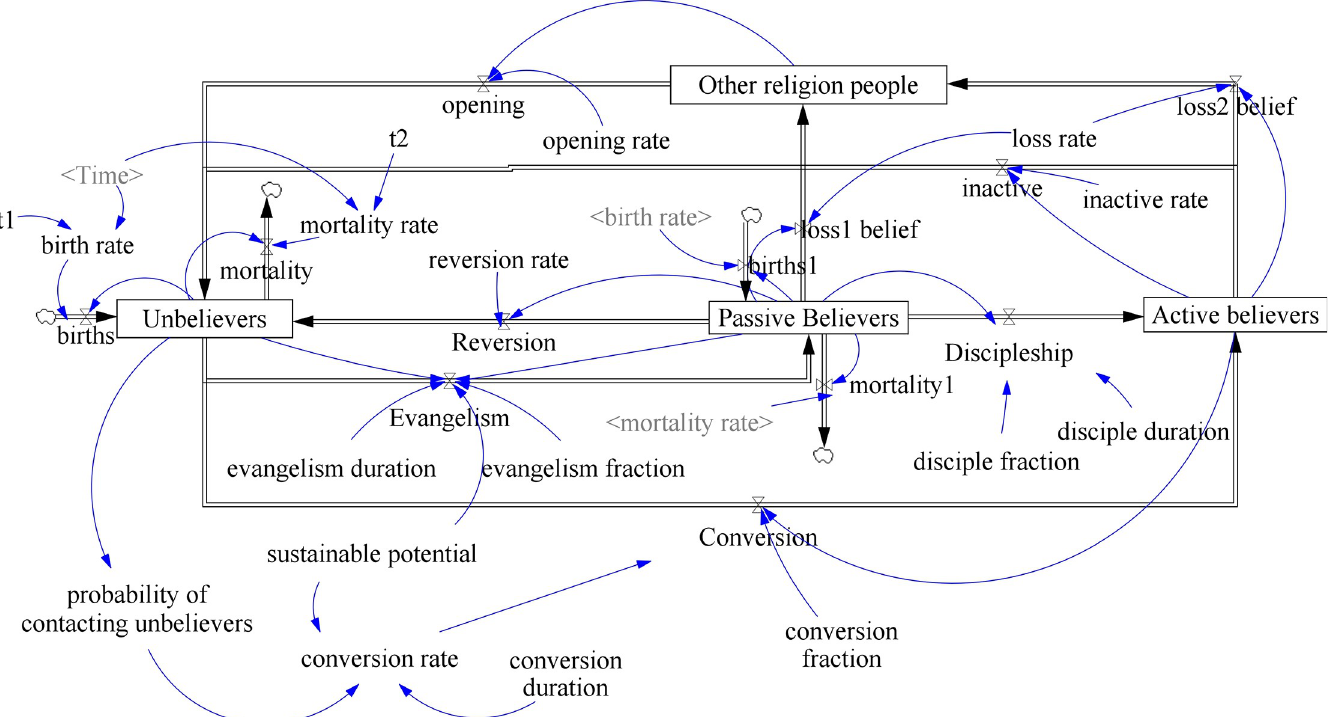
Fig 4. Extended stock and flow diagram for a church population extended to apply to real church population resources (S4 Fig).